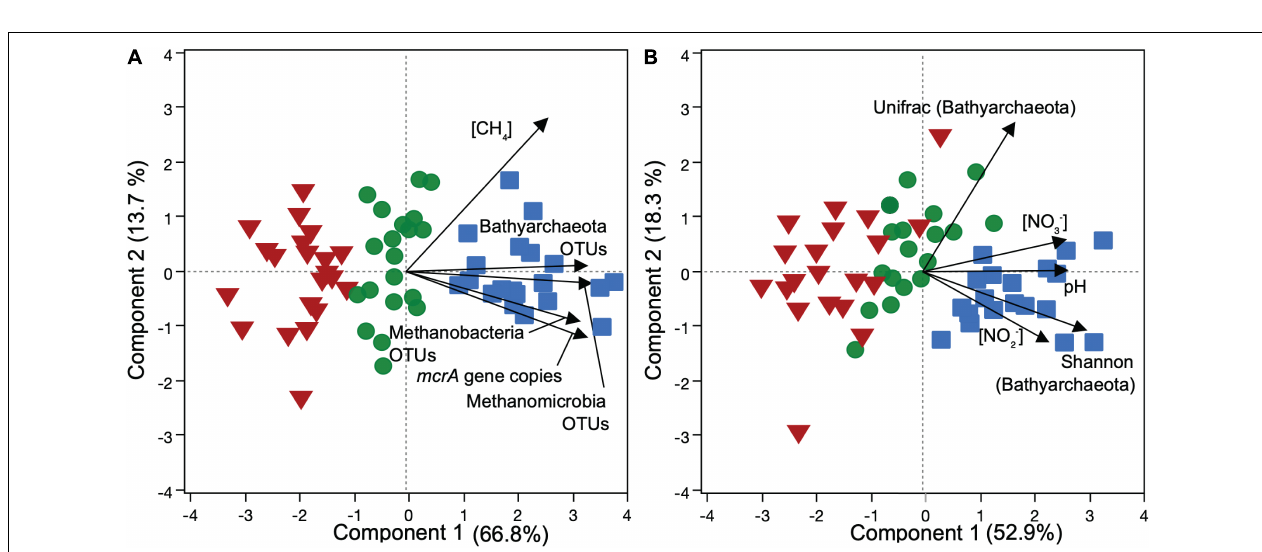
FIGURE 5 | PCA ordination plots of microbial and environmental data from three soil profiles of contrasting Amazon peatlands. Samples were derived from QUI (red triangles), SJO (green circles) and BVA (blue squares) with abbreviations as in Figure 1 . Methane concentration ([CH 4 ]), 16S rRNA gene OTU relative abundances, and mcrA gene copy number (A) , and Bathyarchaeota alpha (Shannon) and beta (Unifrac) diversity indices, NO x concentrations ([NO 2 - ], [NO 3 - ]) and pH (B) were evaluated against microbial distribution. We used Bathyarchaeota abundance and diversity indices as a not yet physiologically resolved close archaeal group important to evaluate but not as assumed